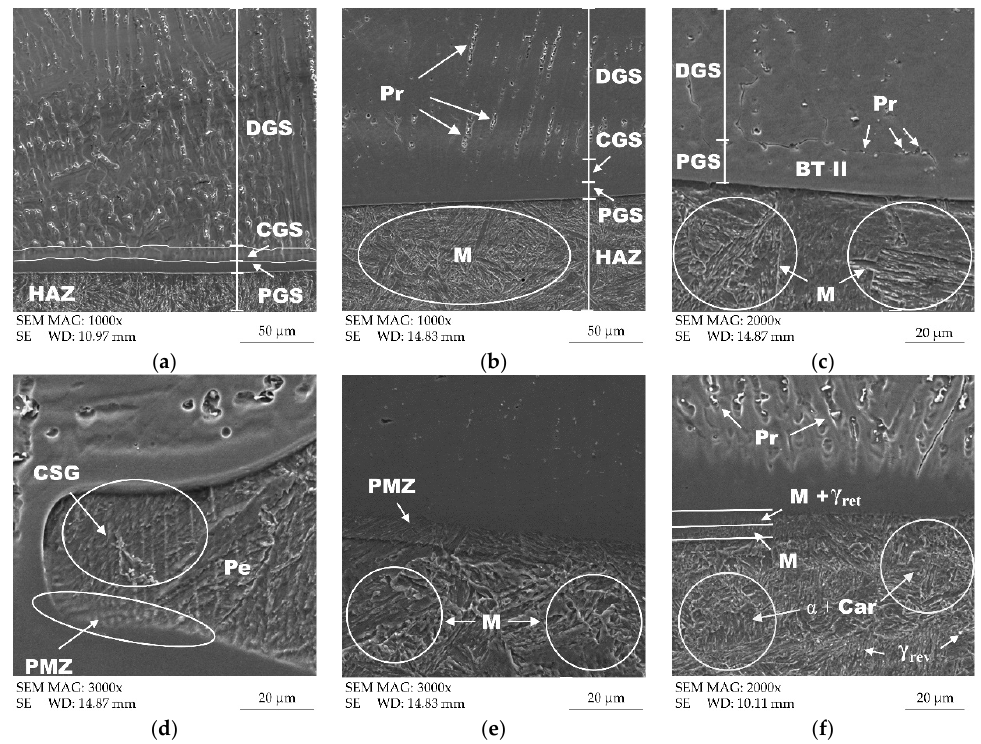
Figure 3. Scanning electron microscopy images of the transition zone of substrate/clad (TZ-S/C): ( a ) overview of the TZ-S/C of clad I, indicating the change from planar growth solidification (PGS) to cellular solidification growth (CSG) and the dendritic-cellular growth separated by white lines; ( b ) a magnified image of ( a ) revealing the presence of martensite (M) in the heat affected zone (HAZ) of 9%Ni and precipitates (Pr) in the interdendritic regions; ( c ) a type II boundary with precipitates (Pr) and the HAZ with lath martensite (M); ( d ) peninsula-like macrosegregation originating from the molten metal, containing a partially mixed zone (PMZ) at the edges (white ellipse), and the cellular morphology of the grains; ( e ) the PMZ containing lath martensite in clad I, and the HAZ with martensite (M); ( f ) the PMZ in clad II with lath martensite (M) and retained austenite ( γ ret ), with the HAZ composed of ferrite ( α ), dispersed carbides (Car), small reverse austenite ( γ rev ) islands, and coarse precipitates (Pr).